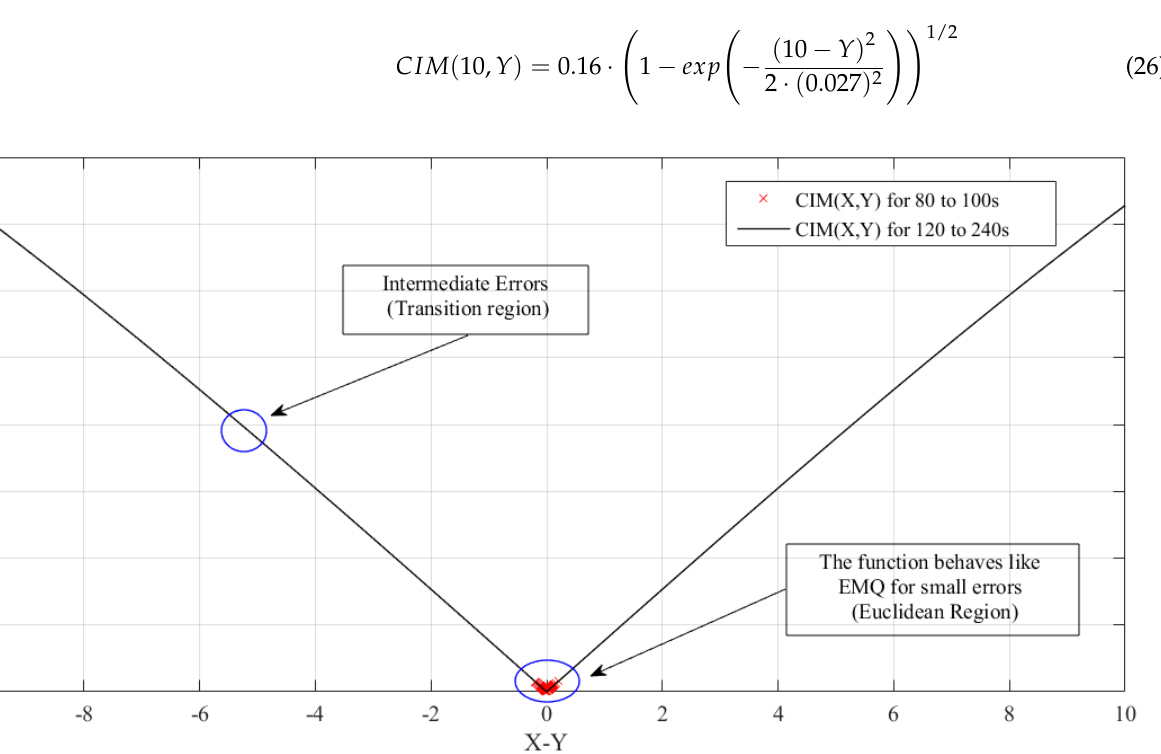
Figure 15. Measurement of the CIM for parametric estimation